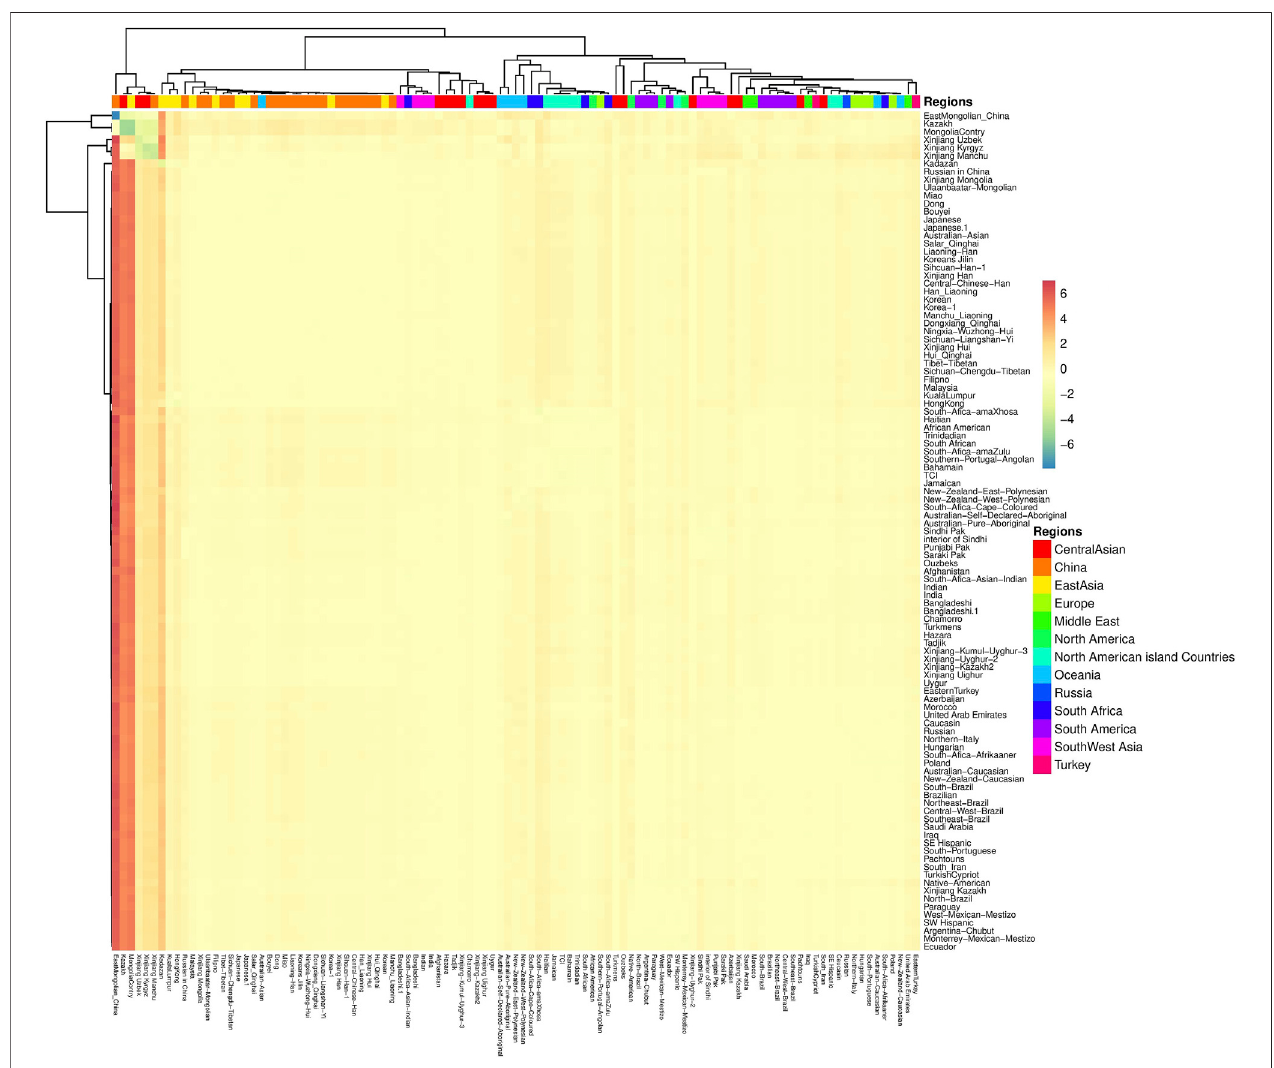
FIGURE 6 | Principal component analysis (PCA) based on Nei ’ s genetic distance revealed by the fi rst two components between the Xinjiang Han population and 104 other reference populations from worldwide.